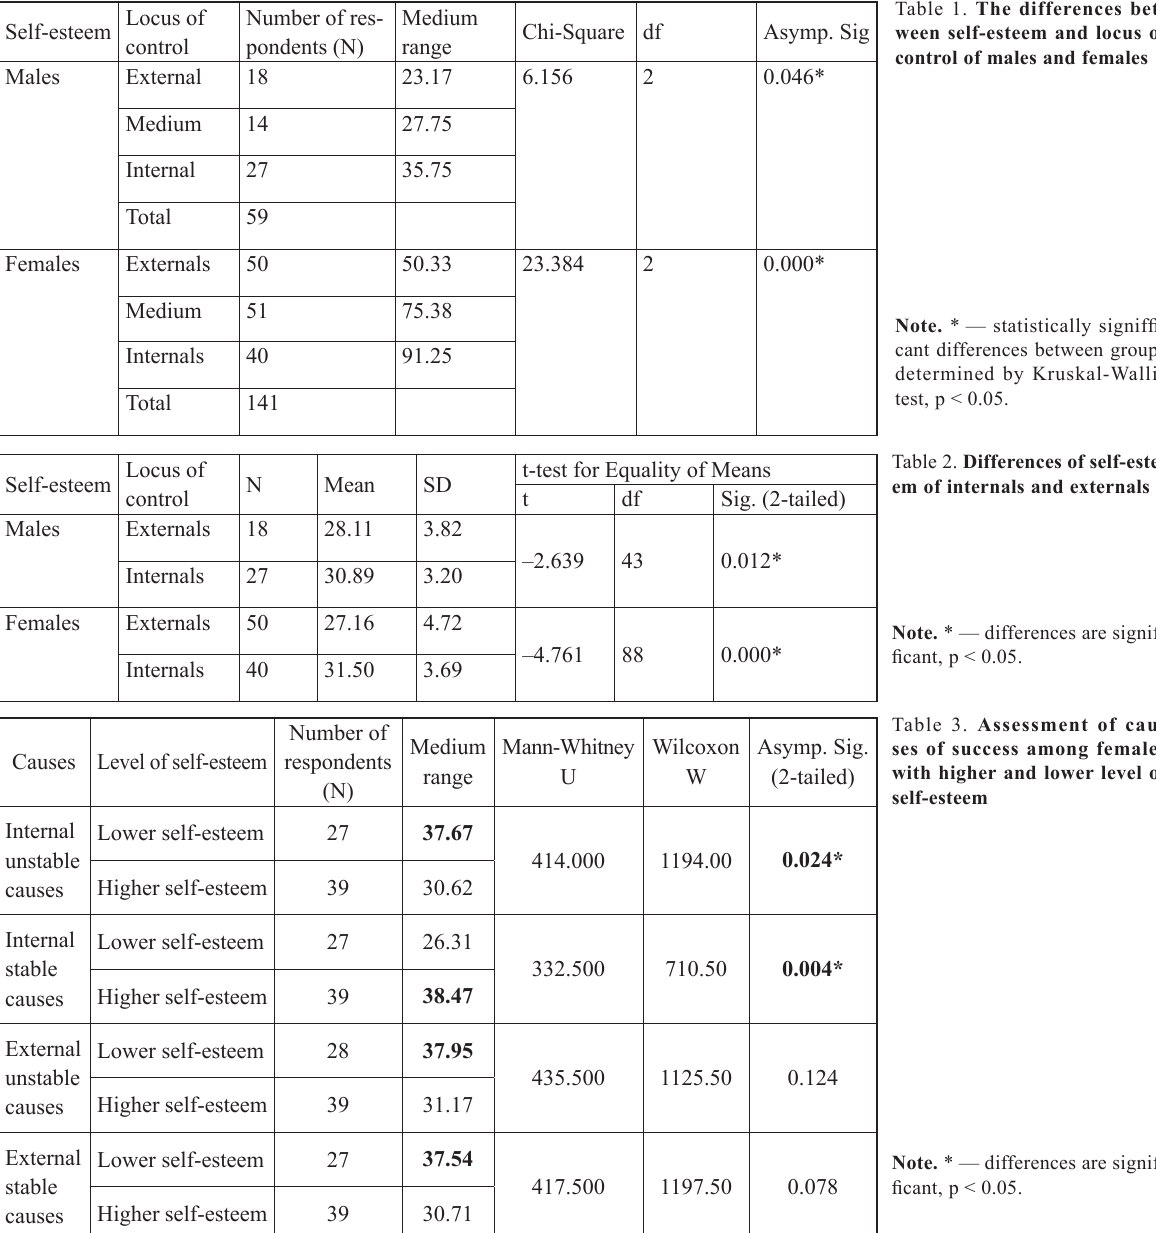
Table 1. The differences bet- ween self-esteem and locus of